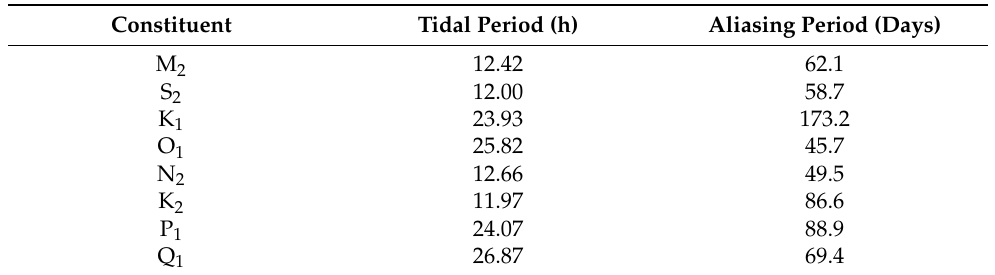
Table 1. The periods and aliasing periods of major tidal constituents under the T/P-Jason sam- pling